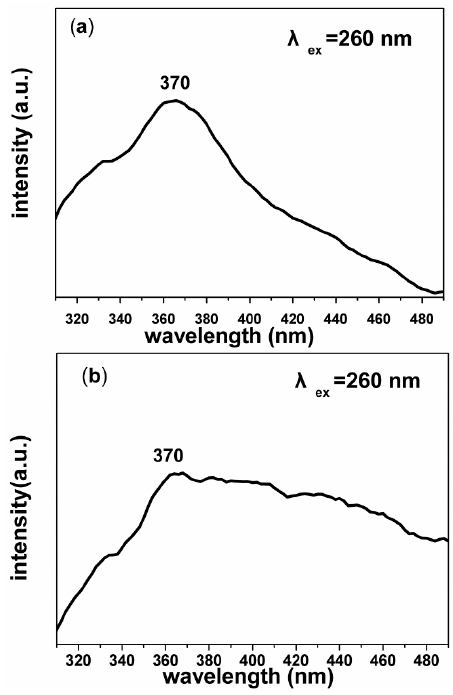
Figure 5. Photoluminescence spectrum of ( a ) SiO 2 sub-micron fibers and ( b ) SiO 2 /ZnO composite hollow sub-micron fibers under excitation at 260 nm ( λ ex = 260 nm).